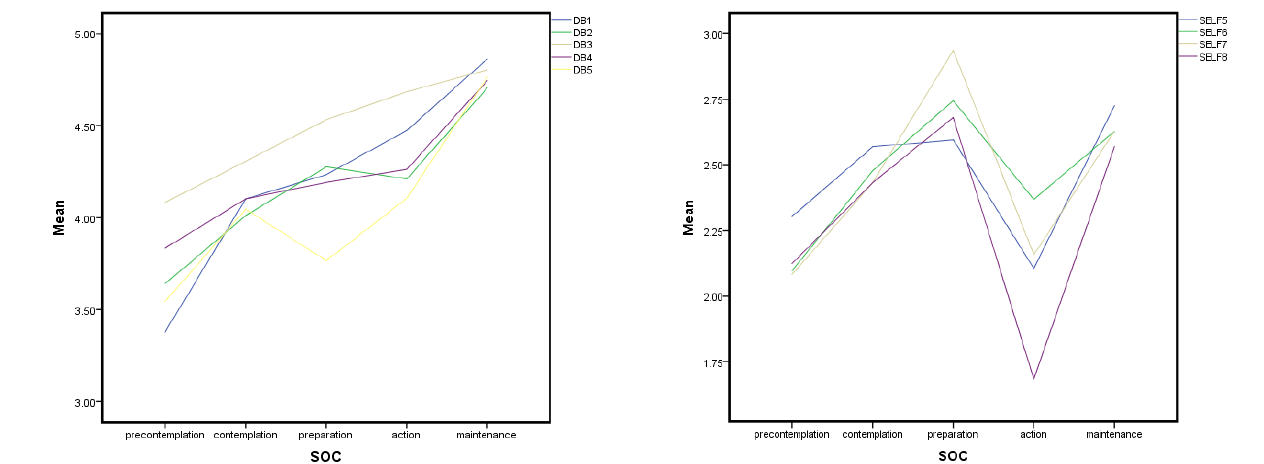
Table 2. One-way ANOVA to compare self-efficacy scores (negative affect situations) across stages of change Negative effect situations Mean SD P value When I feel angry or